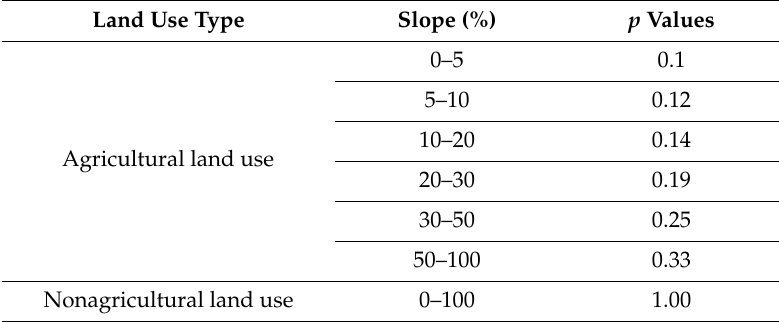
Table 1. Conservation support practice (P) factor values [52].